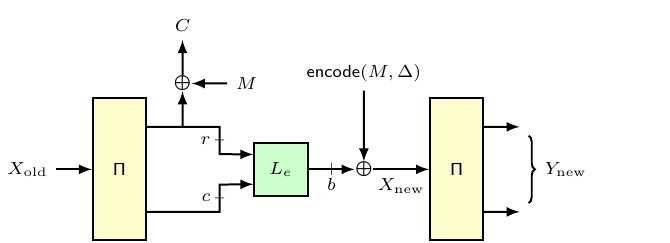
Figure 1: Illustration of the feedback process for a message block M of | M | bits. Here encode ( M, ∆) represents some encoding of | M | bits string to a b -bit string as described above and L e is a linear transformation applied on b -bit strings.